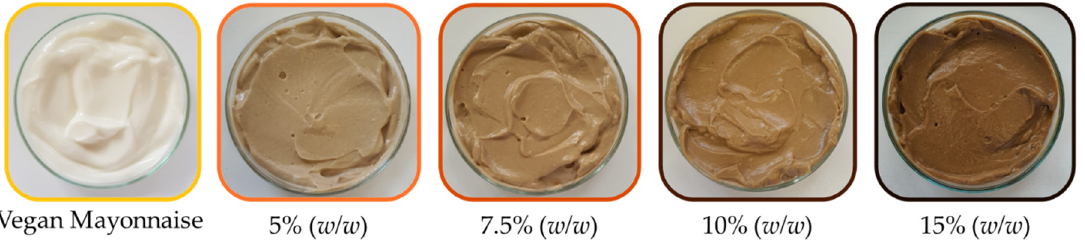
Figure 3. Appearance of emulsions containing 5.0 to 15.0% ( w / w ) of miso paste and the vegan mayonnaise standard.